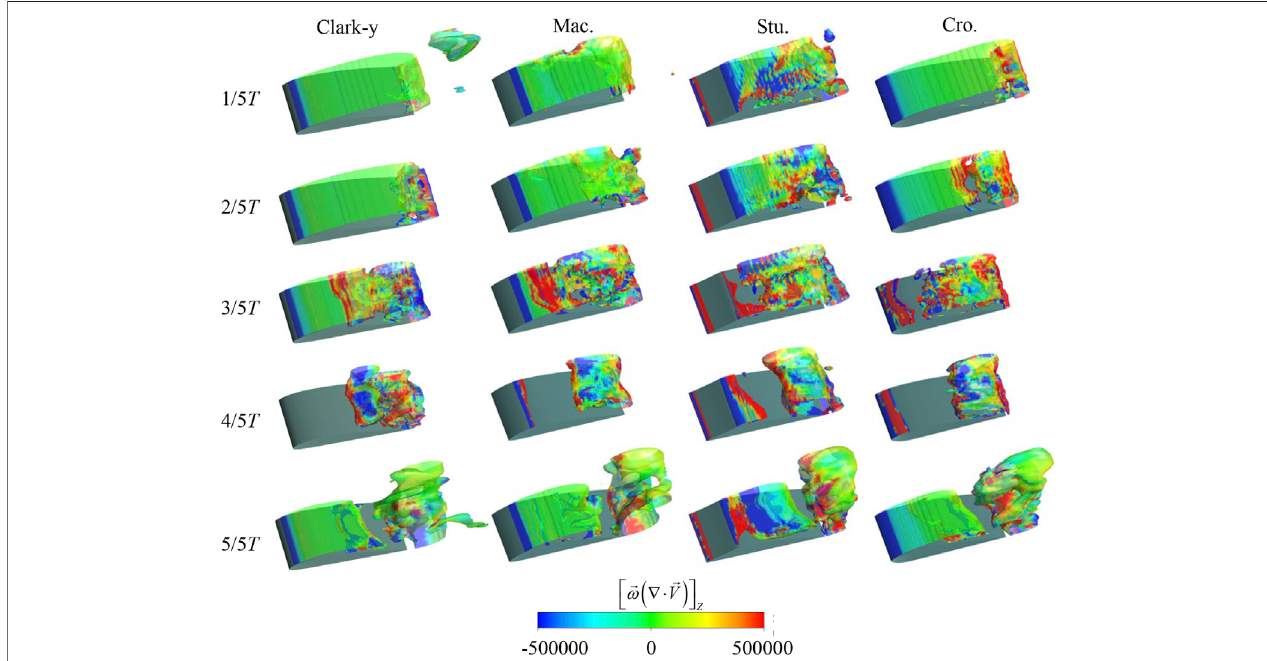
FIGURE 12 | Comparison of the Z-direction vortex dilatation term evolution of the four hydrofoils in a typical cycle.